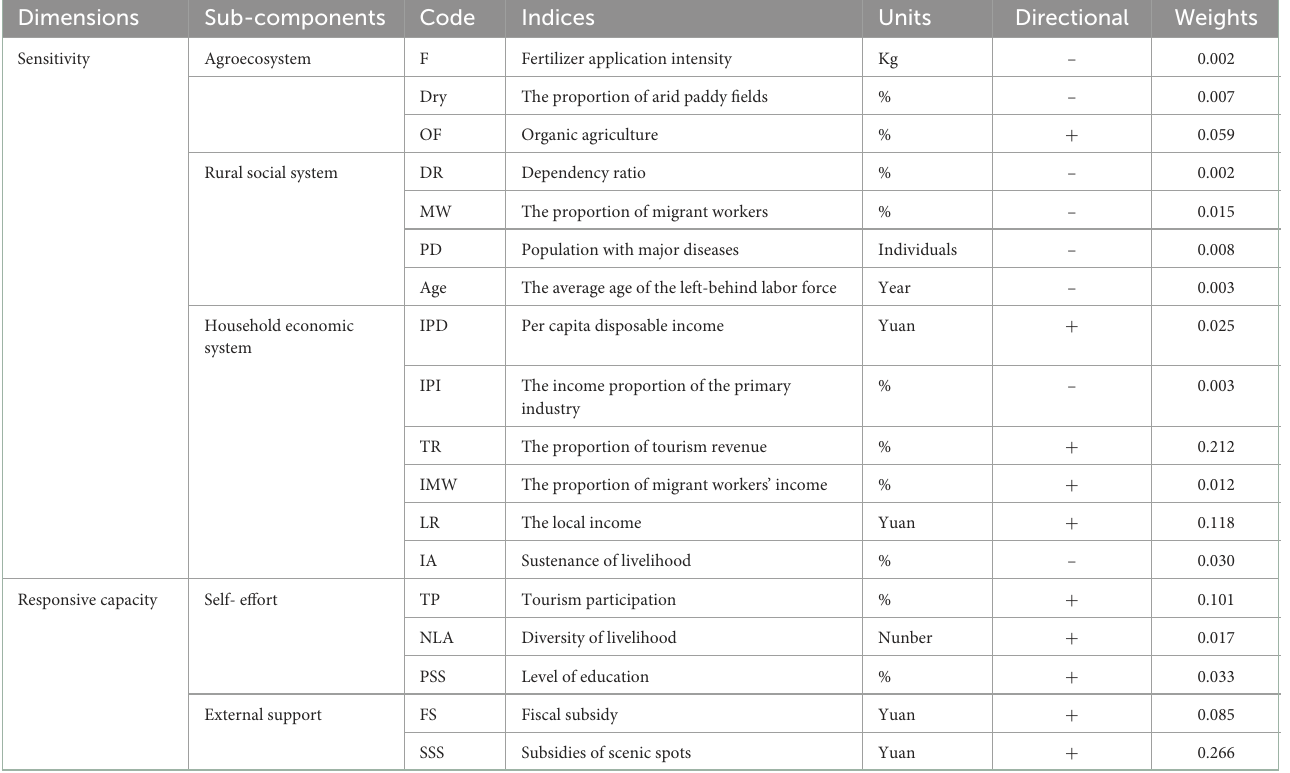
TABLE 1 Indicator system for assessing the livelihood vulnerability of rice terrace